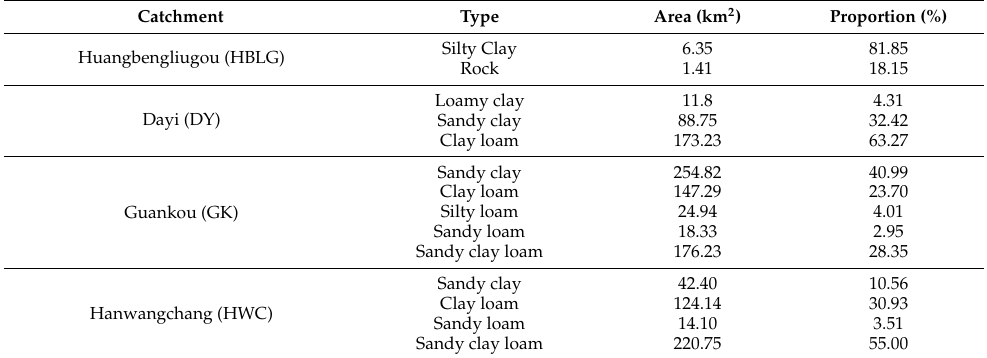
Table 2. Soil texture